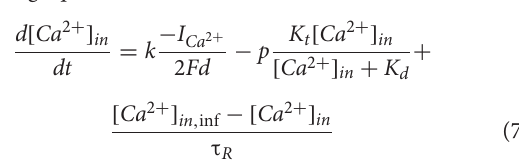
approximated with Equation (6), where P Ca 2 + is the maximum permeability and m , n are different ion channel